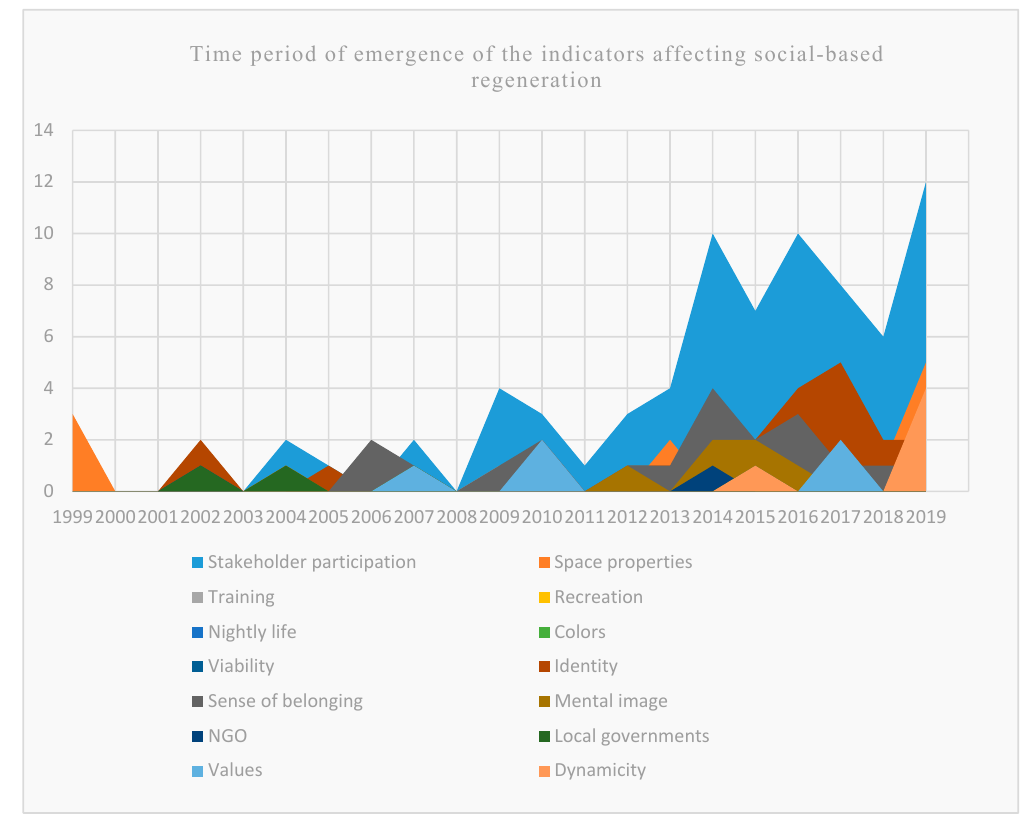
Figure 7. Time period of emergence of the indicators affecting social-led regeneration.